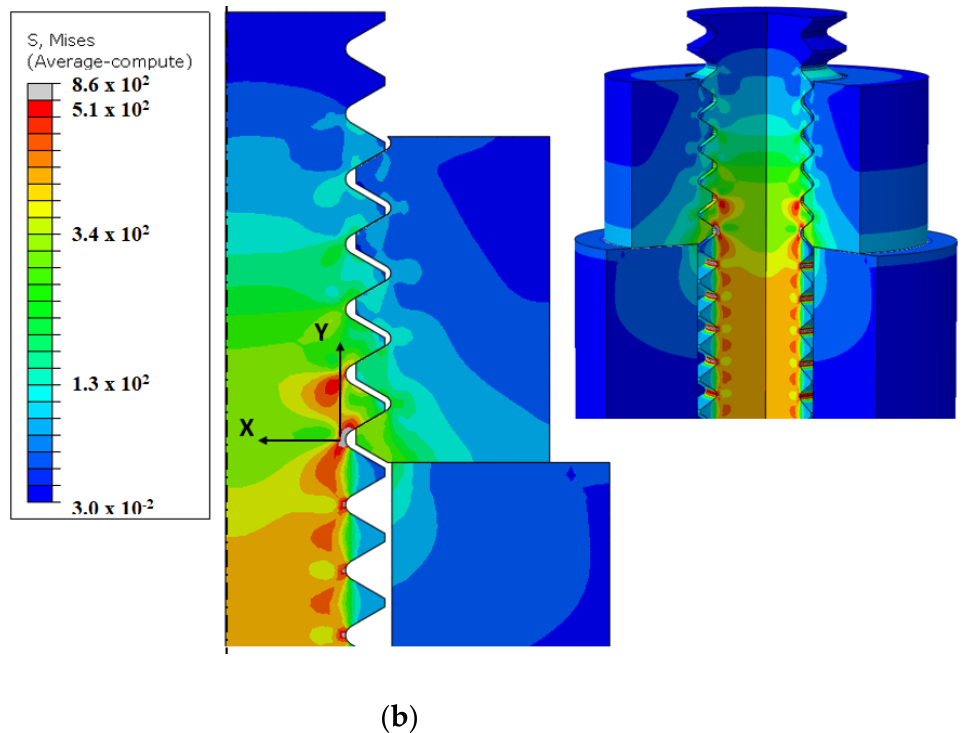
Figure 3. Local coordinate system to quantify stress from the root of the thread ( a ) without nut interface and ( b ) with nut interface.